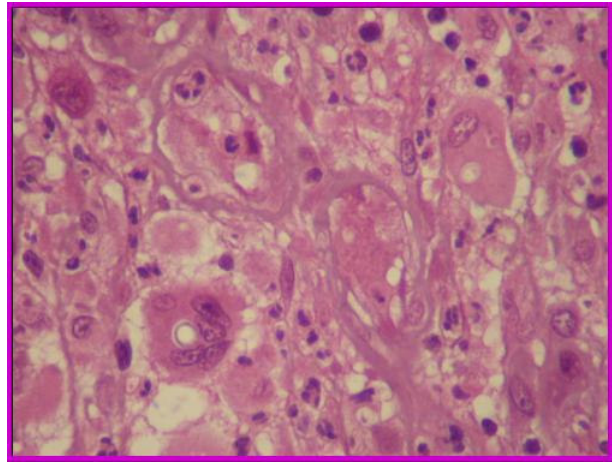
FIGURE 1. B. dermatitidis in bronchial biopsy. Photomicrograph (original magnification ×100, hematoxylin-eosin stain) shows a typical round B. dermatitidis yeast cell with a thick double refractile cell wall and surrounded by granulomatous